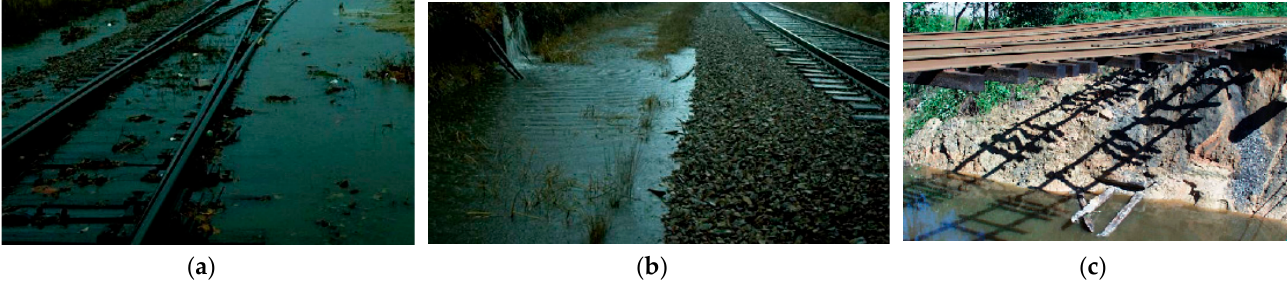
Figure 2. A 1in4 interspersed ballast track [12].